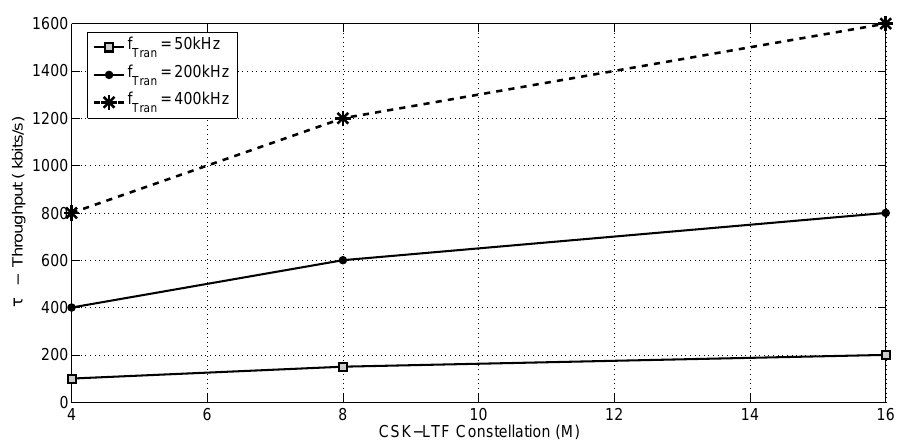
Figure 12. Throughput efficiency for MCSK-LTF